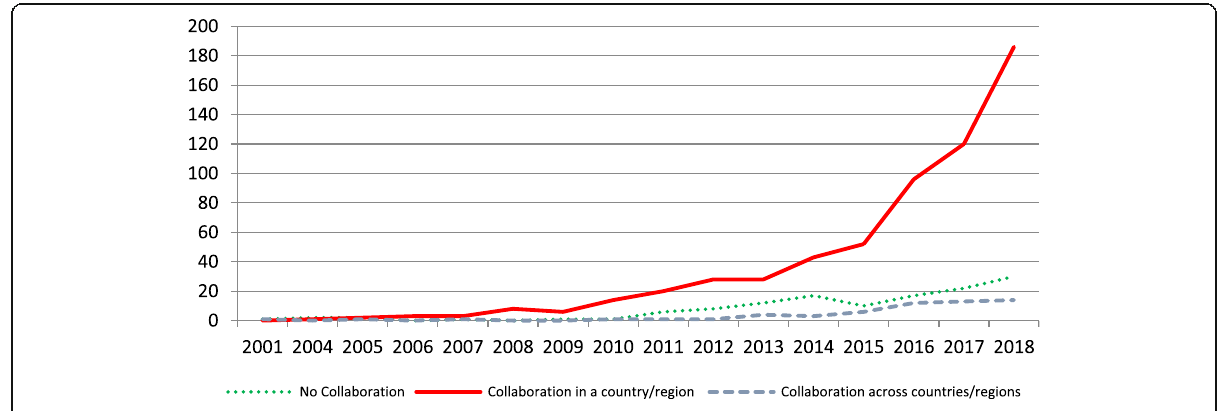
Fig. 10 Publication distribution in authorship across different categories in terms of collaboration over the years